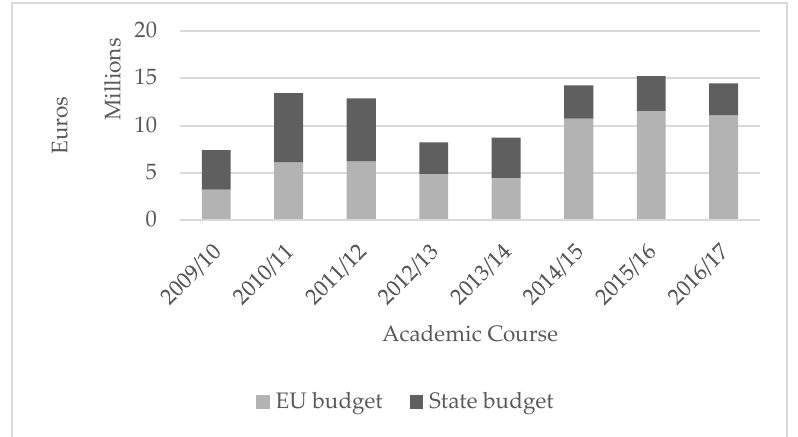
Figure 1. Annual distribution of budget supplied by the EU and the country of Spain for the implementation of the School Fruit and Vegetables Scheme.